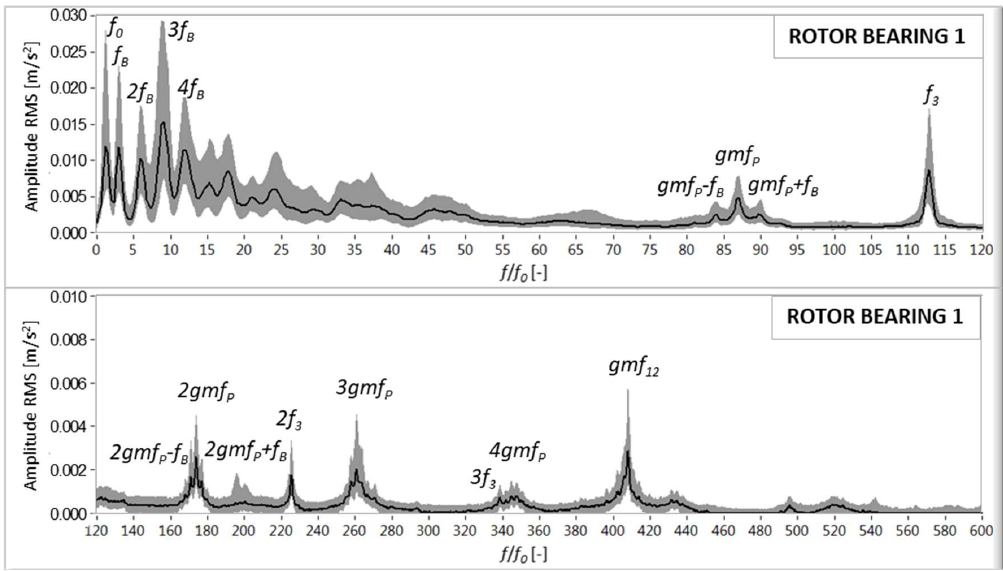
Figure 4. Median spectrum (black line) and amplitude levels between the 25th and 75th percentiles (grey region) of the vibrations measured on the front rotor bearing.